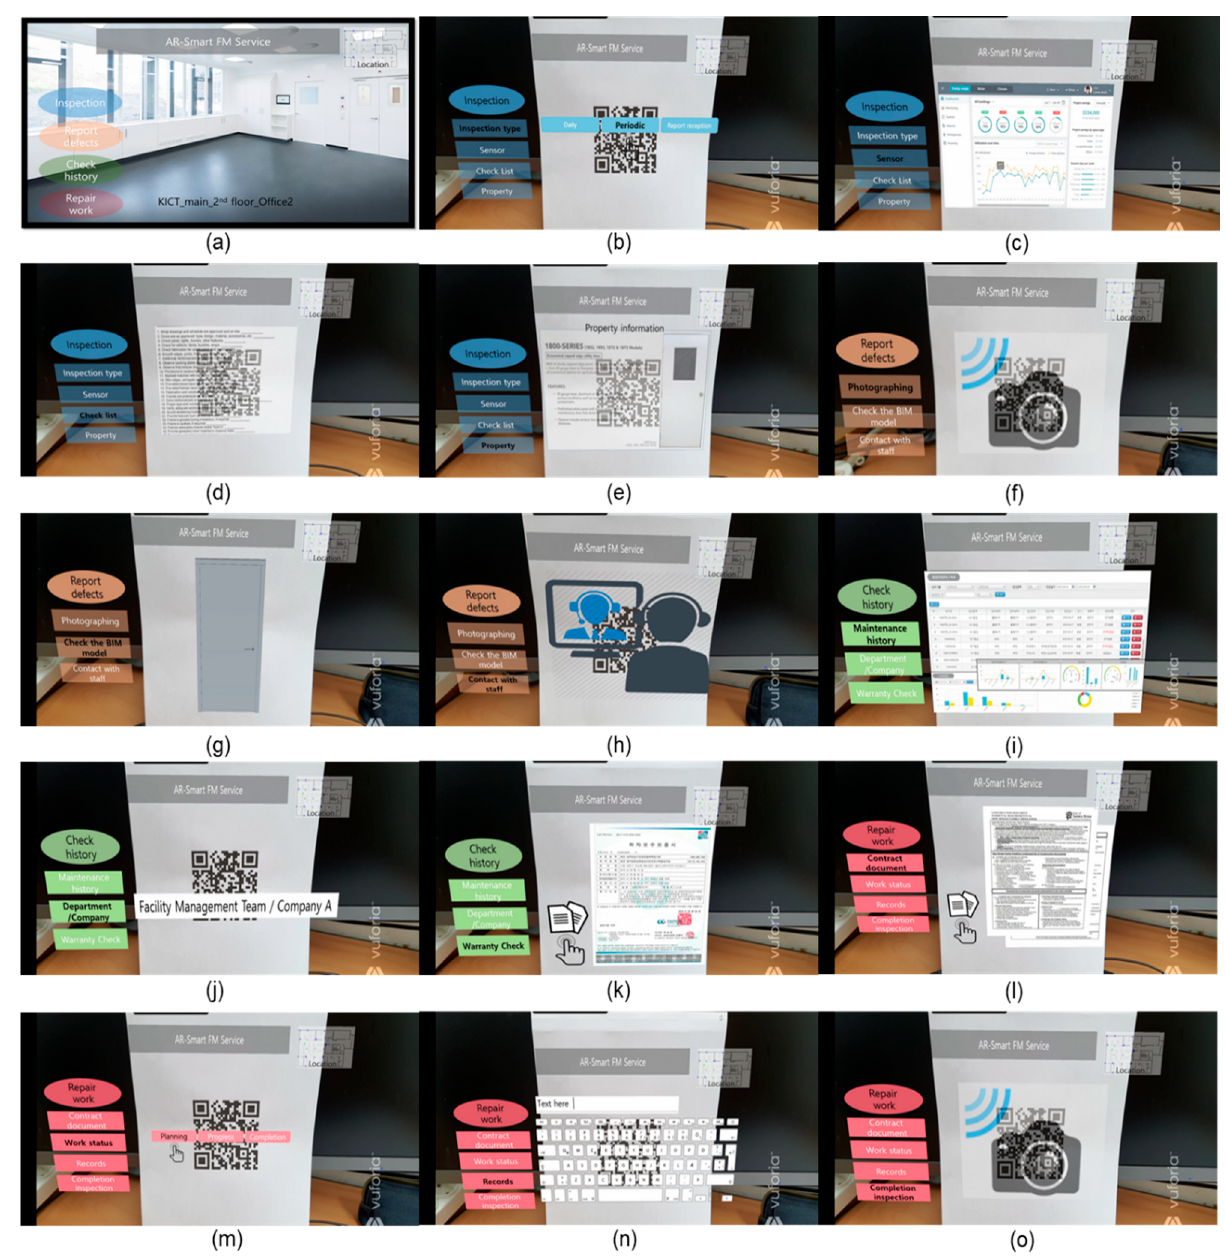
Figure 14. Screenshots of prototype system running the ( a ) Start menu, ( b ) Inspection-Inspection type, ( c ) Inspection-Sensor, ( d ) Inspection-Check List, ( e ) Inspection-Property, ( f ) Report defects-Photographing, ( g ) Report defects-Check the BIM model, ( h ) Report defects-Contact with staff, ( i ) Check history-Maintenance history, ( j ) Check history-Department/Company, ( k ) Check history-Warranty Check, ( l ) Repair work-Contract document, ( m ) Repair work-Work status, ( n ) Repair work-Records and ( o ) Repair work-Completion inspection.